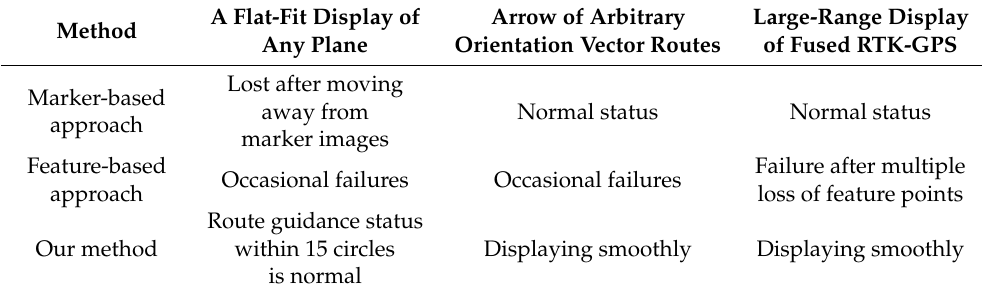
Figure 10. AR map application scenes: ( a ) AT for navigation in a real-world scene. ( b ) AM for AR desktop sandbox. Table 5. Rendering results comparison of all methods in AT.